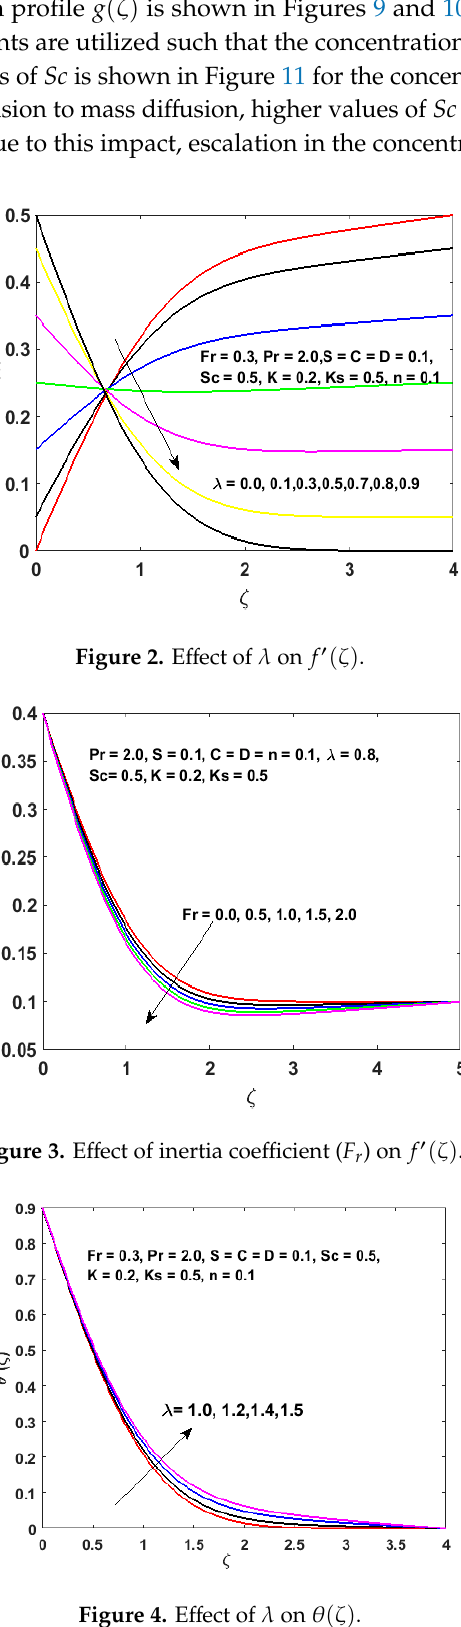
Figure 4. Effect of Figure 4. E ff ect of λ on θ ( ζ )